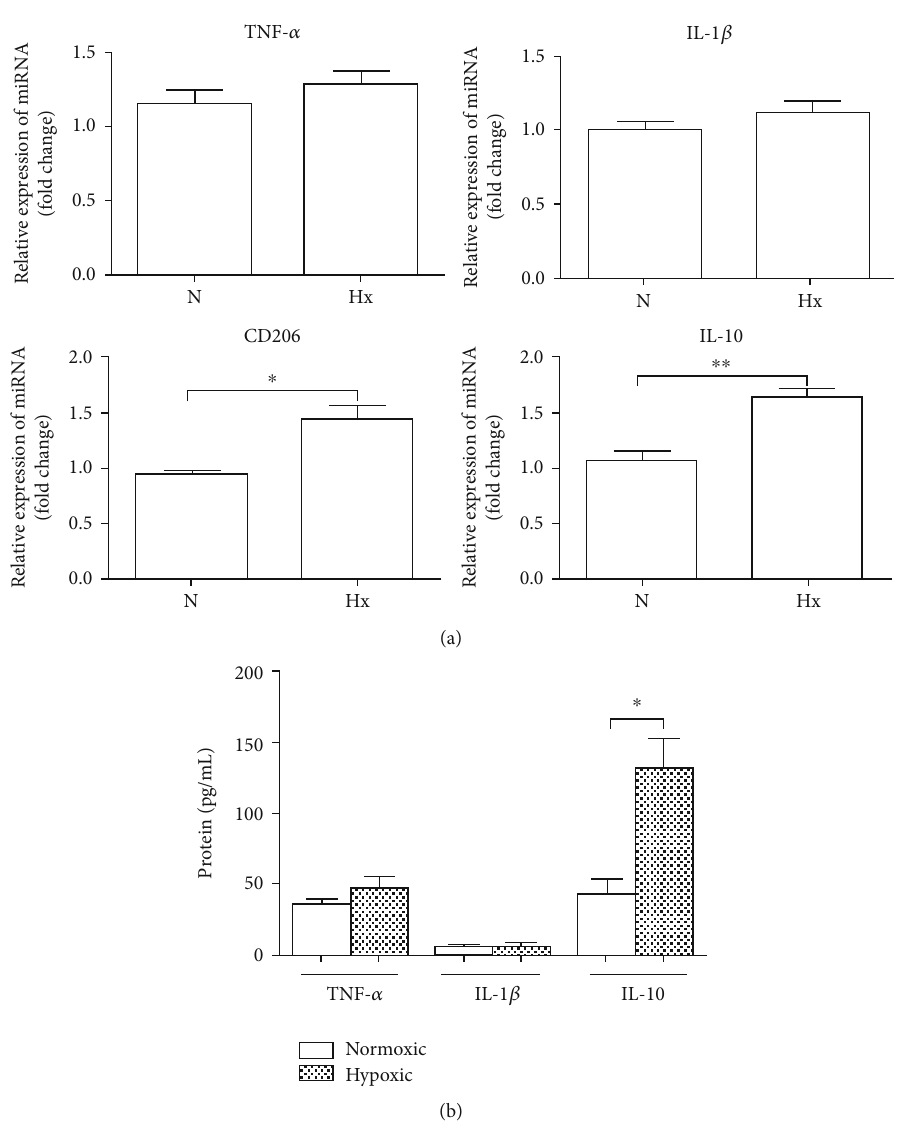
Figure 4: Immunomodulatory e ff ect of exosomes produced by KEL cells on human THP-1 monocytes under hypoxia condition. THP-1 cells were cocultured with exosomes excreted by KEL cells under hypoxia or normoxic condition for 24h. Then, mRNA or protein expression levels of TNF- α , IL-1 β , IL-10, and CD206 were detected. (a) The statistical assay of mRNA expression of TNF- α , IL-1 β , IL-10, and CD206 in THP-1 cells. (b) ELISA assayed the protein levels of TNF- α , IL-1 β , and IL-10 in the supernatants. The results represent three independent experiments. N: normoxia; Hx: hypoxia. ∗ P < 0 : 05 , ∗∗ P < 0 : 01